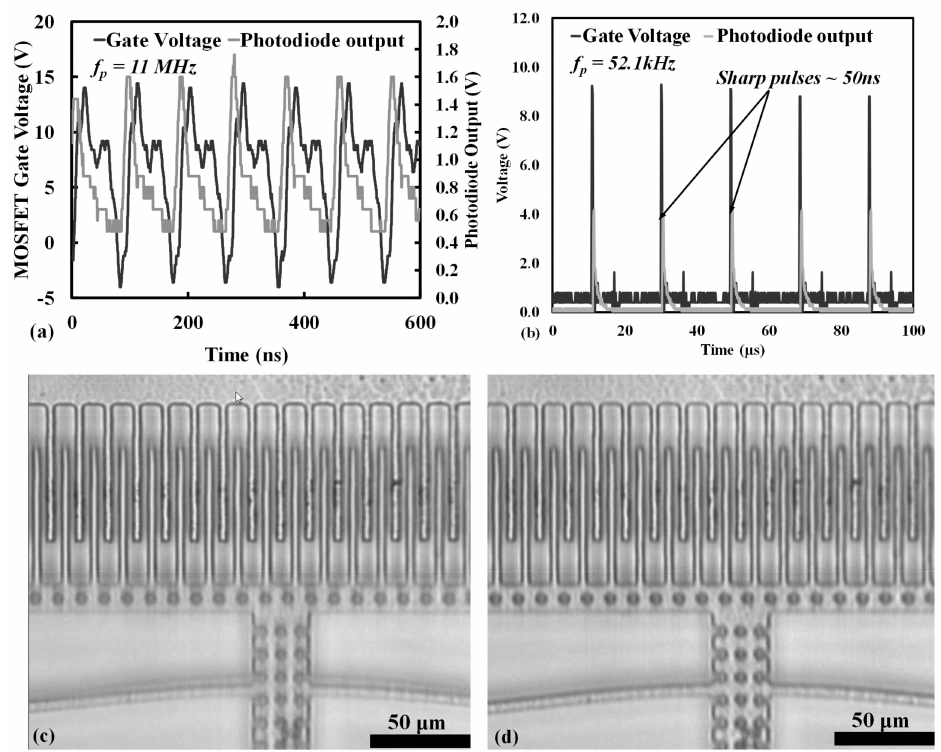
Figure 13. Performance limits of the imaging system. ( a ) The imaging system is shown to work well at srtobing frequencies up to 11 MHz frequency as shown by the pulsed LED output detected by a high-speed photodetector placed at the camera c-mount; ( b ) The sharpening of the LED pulses is shown at the resonant frequency of 52.1 kHz with 50 ns sharp pulses from an R*C differentiator; Figure ( c ) shows the motion blurring in the captured image at 52.1 kHz with rectangular 190 ns strobe pulse widths as achieved from a divide by 100 counter; ( d ) shows a reduction in motion blurring when the LED signal is sharpened with a differentiation circuit producing 50 ns wide strobe